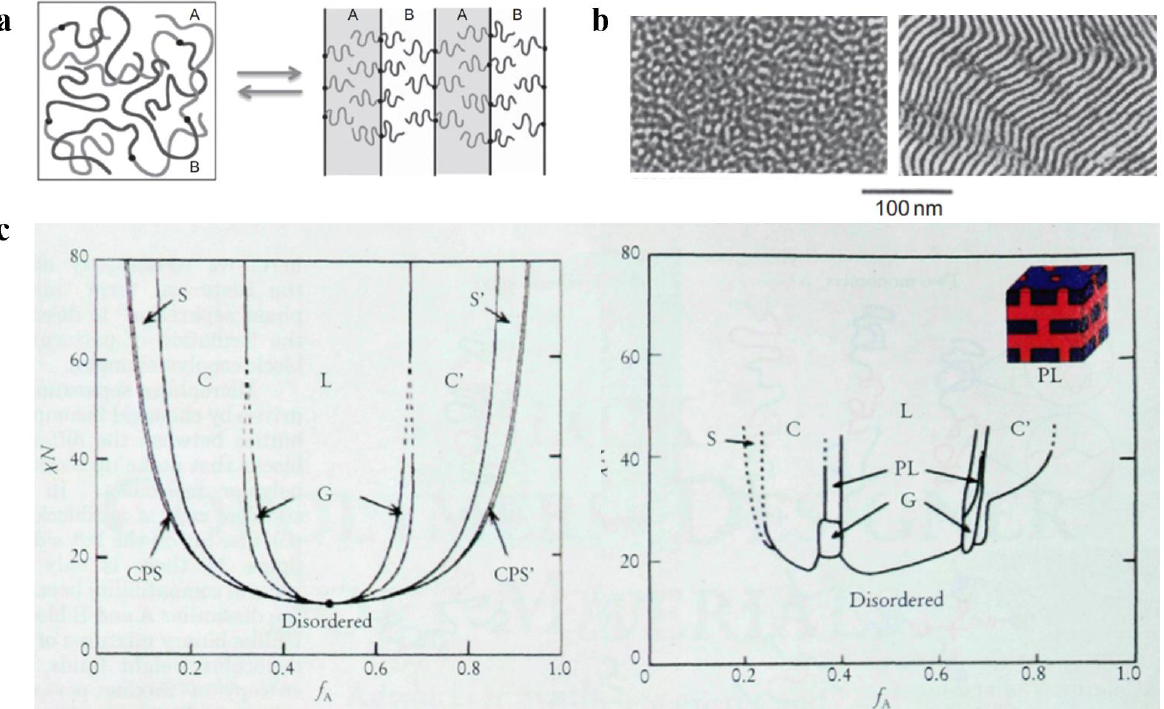
Figure 1. ( a ) Molecular chain distribution of AB-type diblock copolymer before and after the ODT [37]. ( b ) TEM images of PS-b-PI before and after the ODT [37]. ( c ) Theoretical phase diagrams predicted by the self-consistent field theory of the linear AB diblock copolymer and the actual phase diagram (spherical (S, S’), cylindrical (C, C’), bicontinuous gyroidal (G), and lamellar (L)) obtained from the PS-b-PI